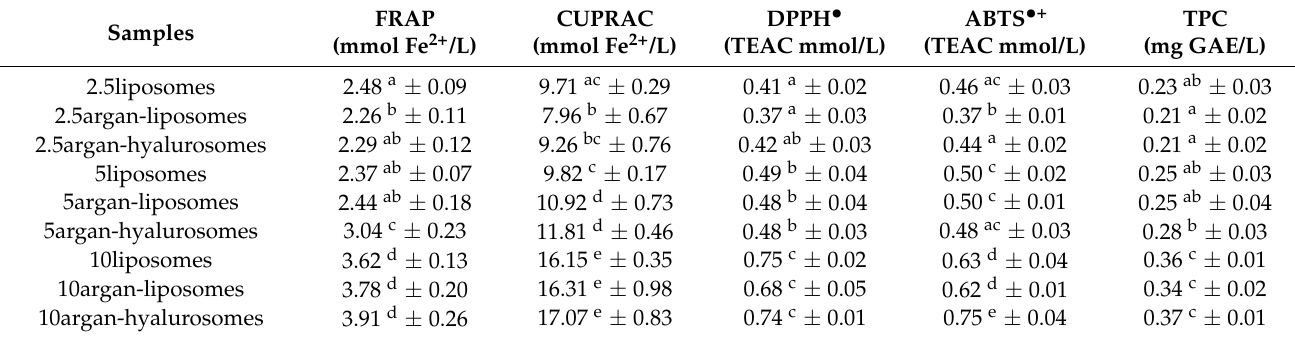
Table 2. Total phenol content and antioxidant power of the formulations. FRAP and CUPRAC values are expressed as Fe 2+ mmol/l, DPPH • and ABTS • + values are expressed as Trolox equivalent antioxidant capacity (TEAC, mmol/L), total phenol content measured by Folin-Ciocalteu’s assay is expressed as gallic acid equivalent (GAE). Mean values ± standard deviations have been reported. Means in each column not sharing a superscript letter are significantly different ( p ≤ 0.05).